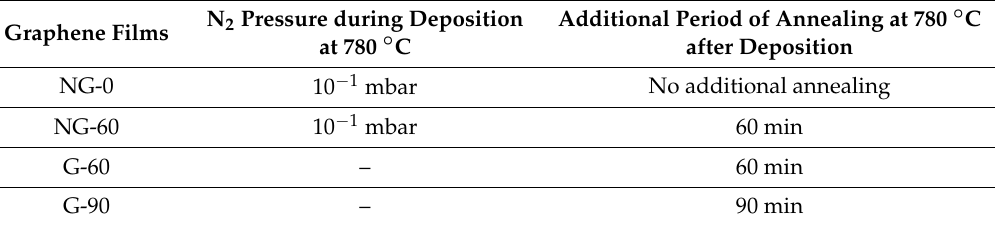
Table 1. Specific deposition parameters of the graphene